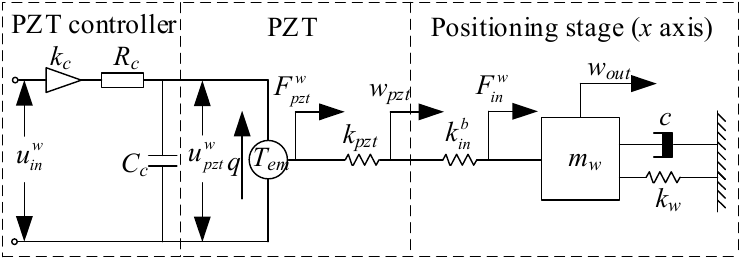
Figure 3. Simplified electromechanical coupling model.